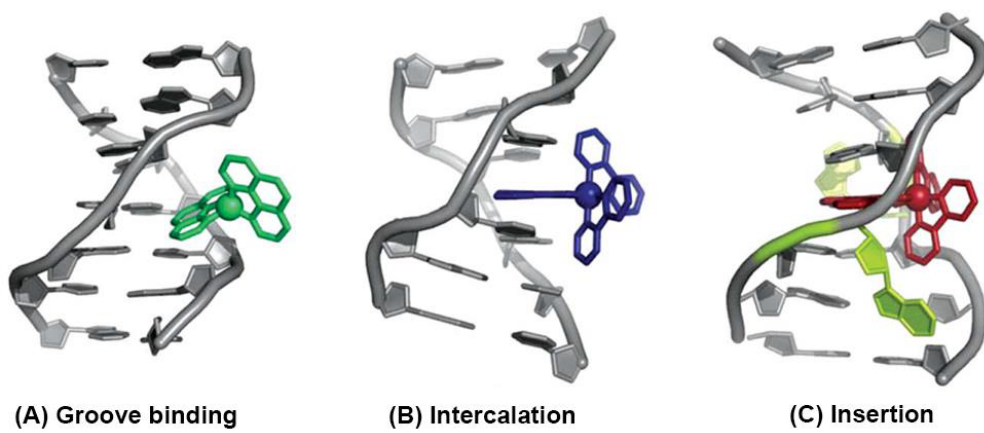
Figure 1. The three binding modes of metal complexes with B-DNA: ( A ) groove binding, ( B ) intercalation, and ( C ) insertion (reproduced with permission from Reference [18]).